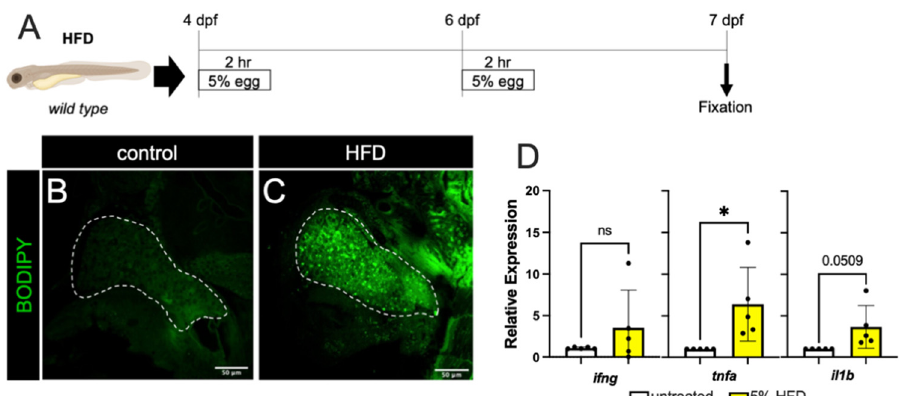
Figure 1. High fat diet treatment. ( A ) The schematic for high-fat diet feedings of the zebrafish larvae. ( B,C ) BODIPY labeling of unfed ( B ) and 5% High-fat Diet (HFD) fed larvae ( C ). There is minimal accumulation of lipid droplets in the liver of unfed larvae (outlined by dashed white line), while HFD treatment resulted in significant accumulation of lipid droplets in hepatocytes. ( D ) The larval mRNA level of tnfa only is significantly increased in response to HFD. Expression analyses were performed on whole larvae. Statistical analyses by students t-test, n = 4–5 clutches with at least 15 embryos per clutch. ns—not significant,* p < 0.05.